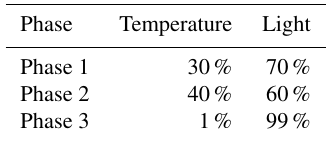
Table 4. Simulated contribution of light and temperature limitation during the three phases of the MPB seasonal